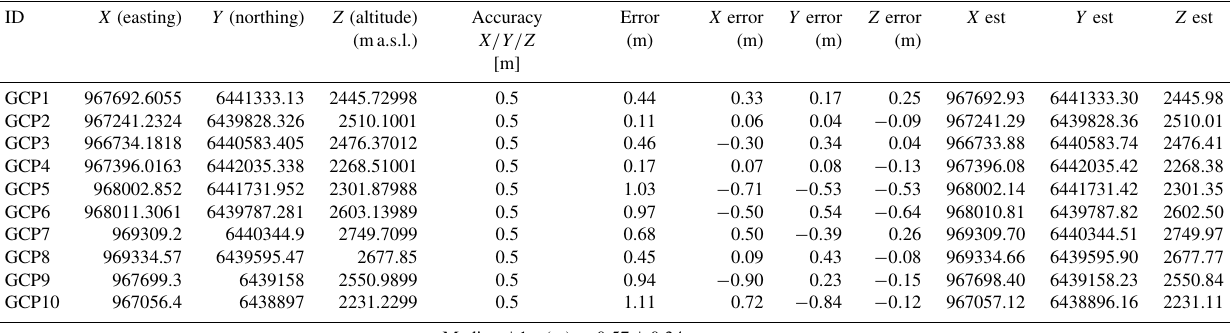
Table A1. Statistics of the ground control points (GCPs) used for the co-registrations of the two orthomosaics. Coordinates are mentioned in the EPSG:2154–RGF93 v1/Lambert-93